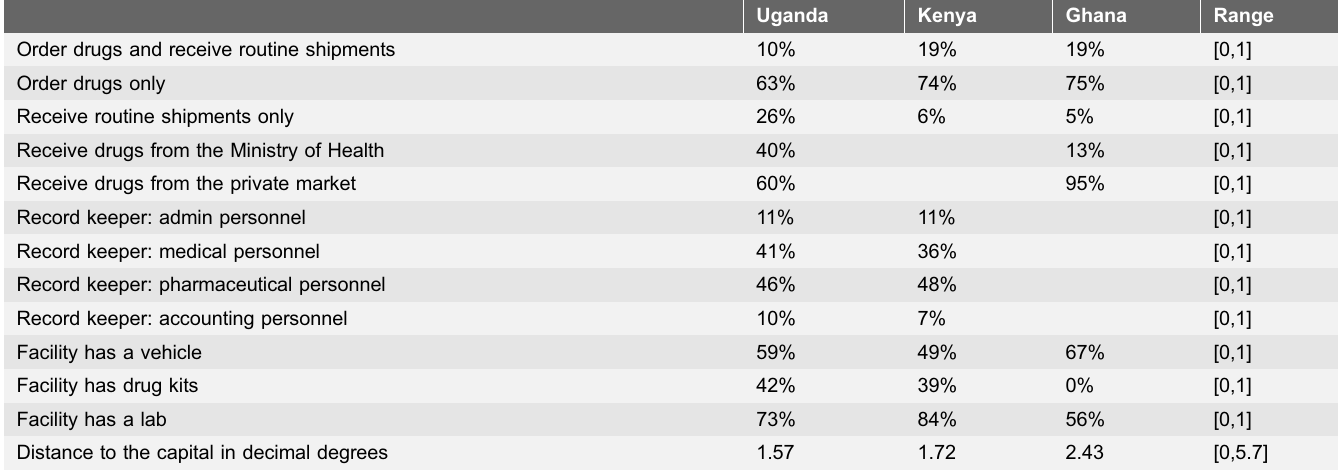
Table 2. Facility level characteristics by